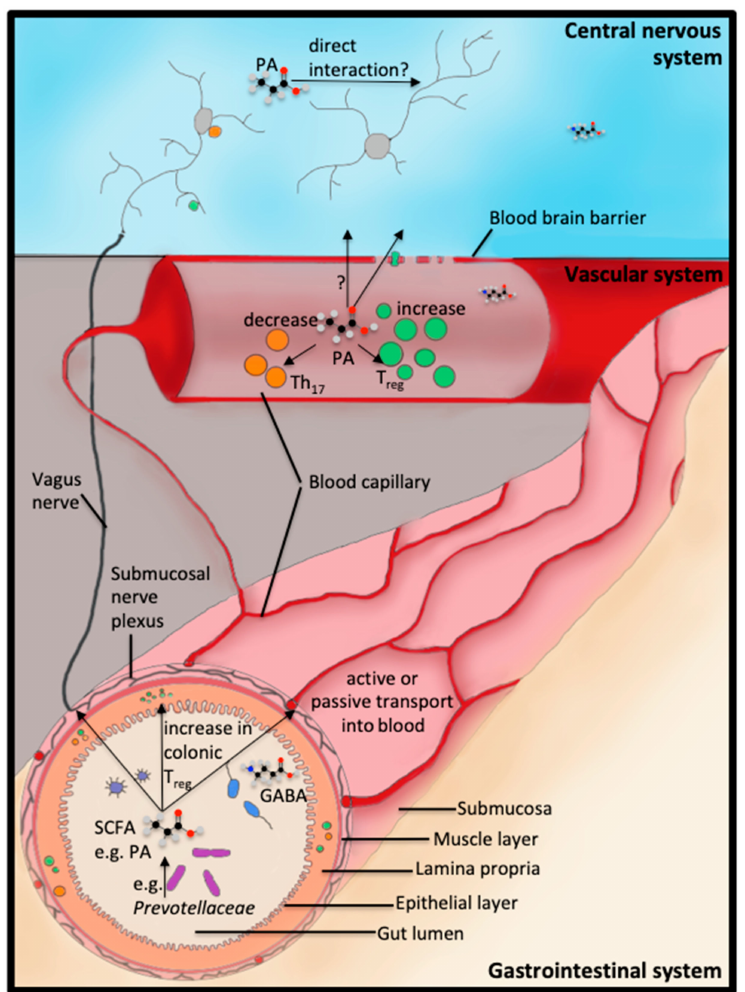
Figure 1. The gut and the brain—interacting systems. The central nervous system is in direct contact with the gastrointestinal system through the enteric nervous system and the vagus nerve. Furthermore, gut microbiome-produced metabolites, like the short chain fatty acid (SCFA) propionic acid (PA) or the neurotransmitter γ -Aminobutyric acid (GABA), can take the indirect route of the vascular system to finally reach the central nervous system